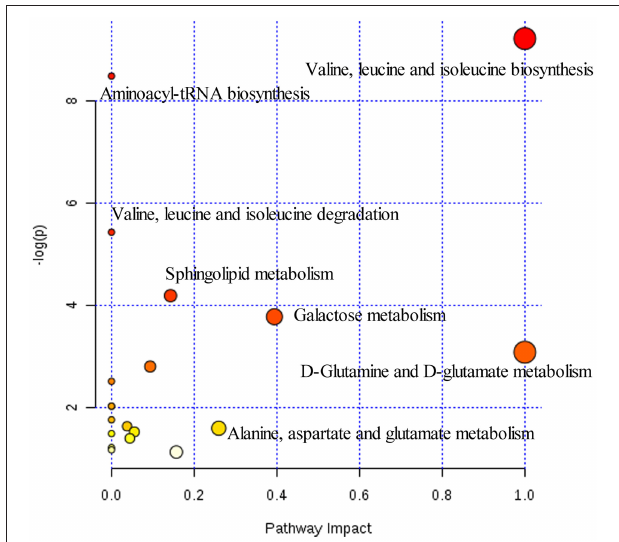
FIGURE 5 | Summary of pathways analysis of CUMS rats with PBR treatment with MetaboAnalyst. Each point represents one metabolic pathway; the size of dot and shades of color are positively correlated with the impact on the metabolic